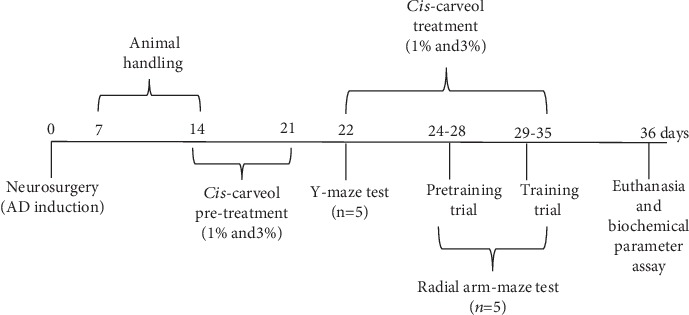
Experimental design.